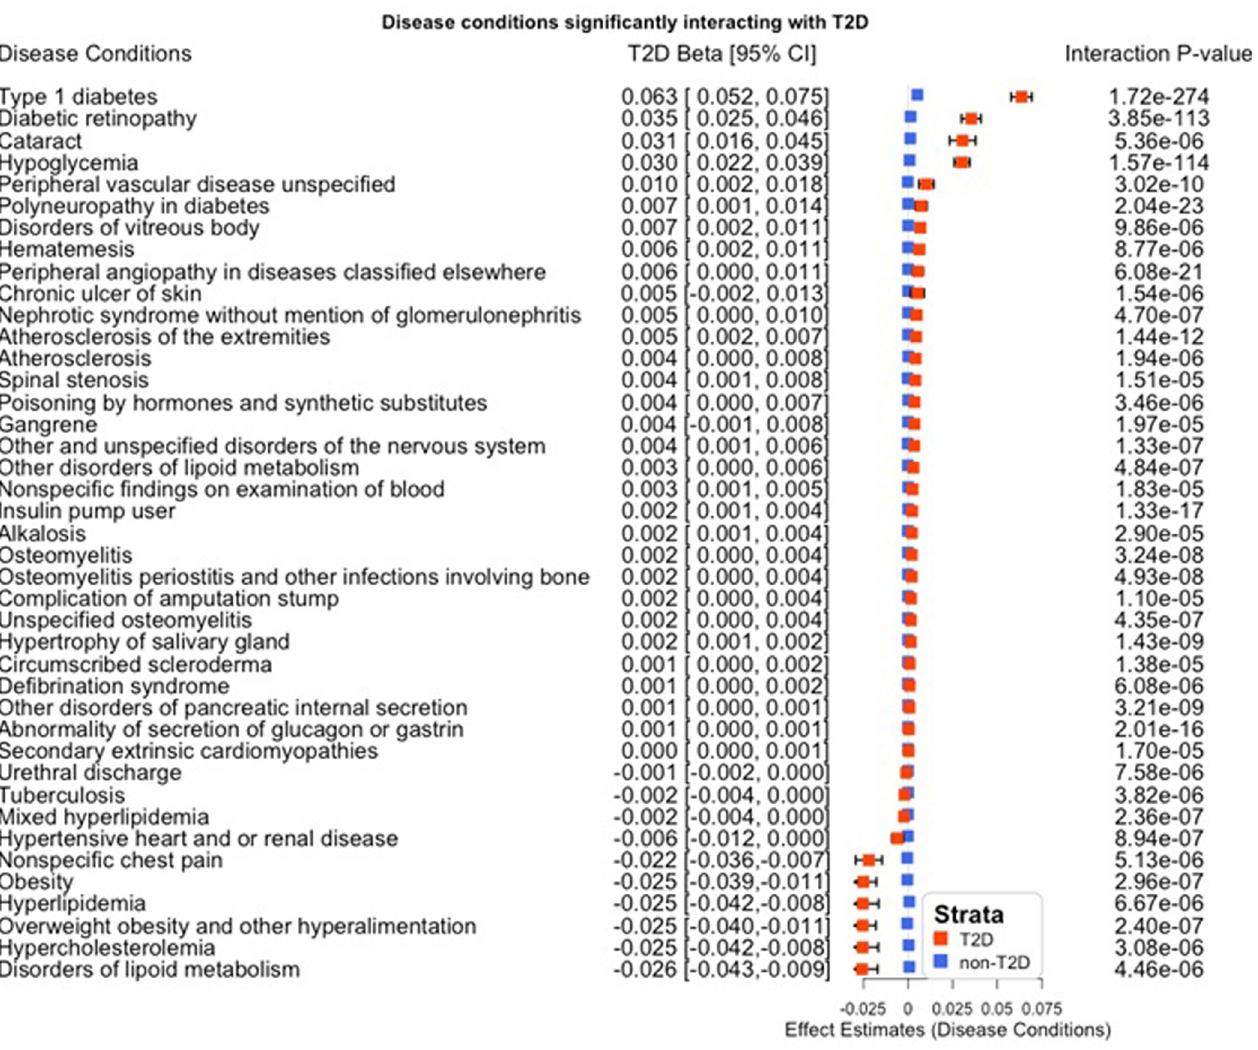
Fig 3. Phenome wide association (PheWAS) of disease conditions stratified by T2D status. Interaction between the rs9274619:A and T2D with multiple disease conditions as outcomes (combination of incidence and prevalence) was modeled while adjusting for all covariates (sex, age, age 2 , race, PC1-10). Bonferroni corrected 45 significant phenotypes were stratified by T2D status and analyzed using logistic regression. The T2D effect estimates for rs9274619:A and the interaction p-value are documented, the disease conditions are ordered based on T2D beta. From the 45 disease conditions tested, highly correlated Type1 diabetic conditions were removed while plotting the figure. PC–Principal Components; PheWAS–Phenome Wide Association Studies; T2D –Type 2 Diabetes.